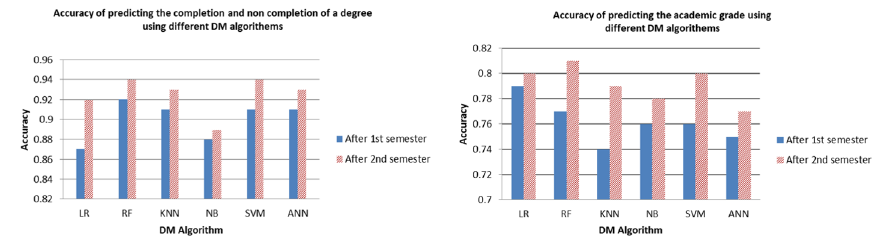
Fig. 4 A comparison between the accuracy of the academic predictions performed after the 1st semester and those performed after the 2nd